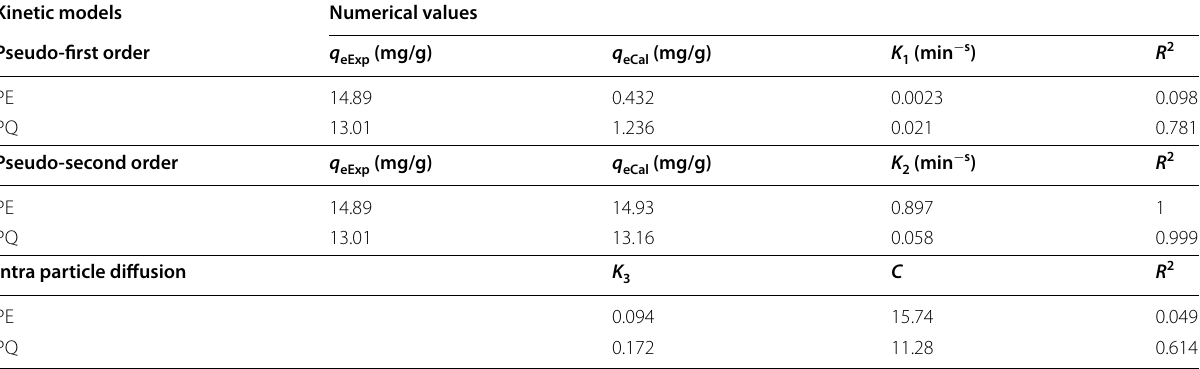
Table 2 Parameters for the kinetic adsorption of PE and PQ onto ACBGNS Kinetic models